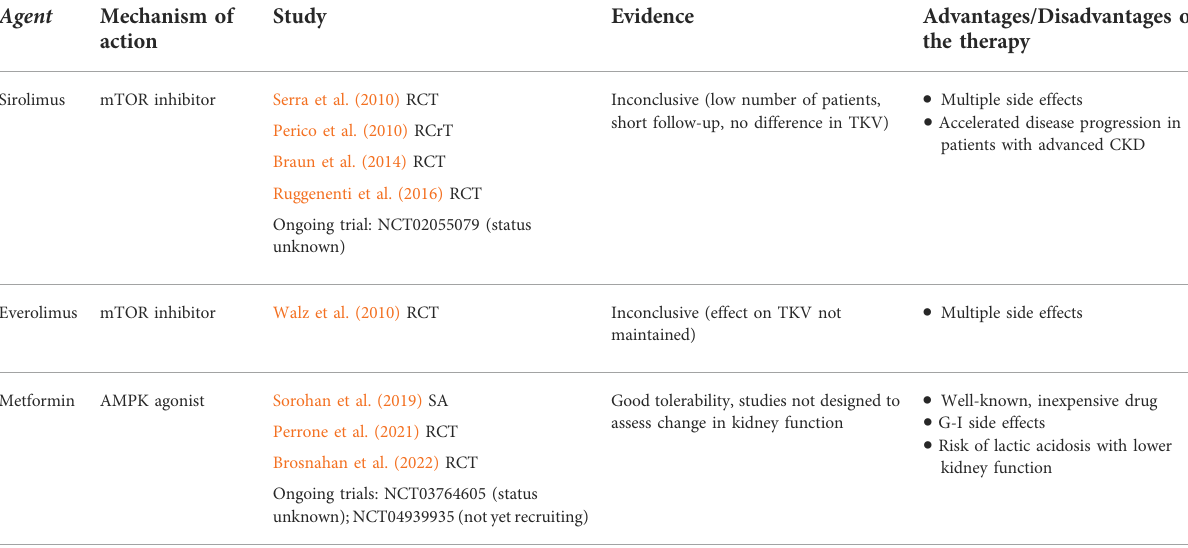
TABLE 2 Clinical studies investigating metabolic agents of interest in the treatment of ADPKD.